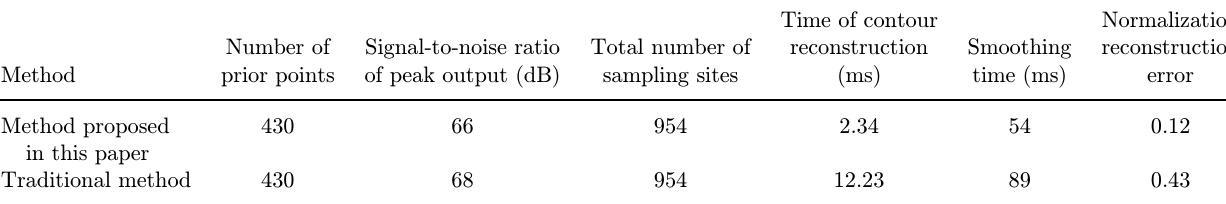
Table 1. Performance comparison of contour reconstruction of three-dimensional spiral CT damage